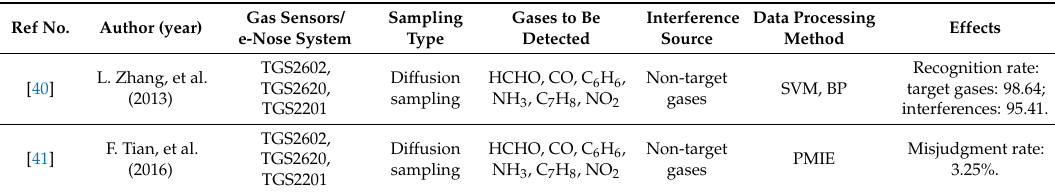
Table 3. Methods for the dynamic interference